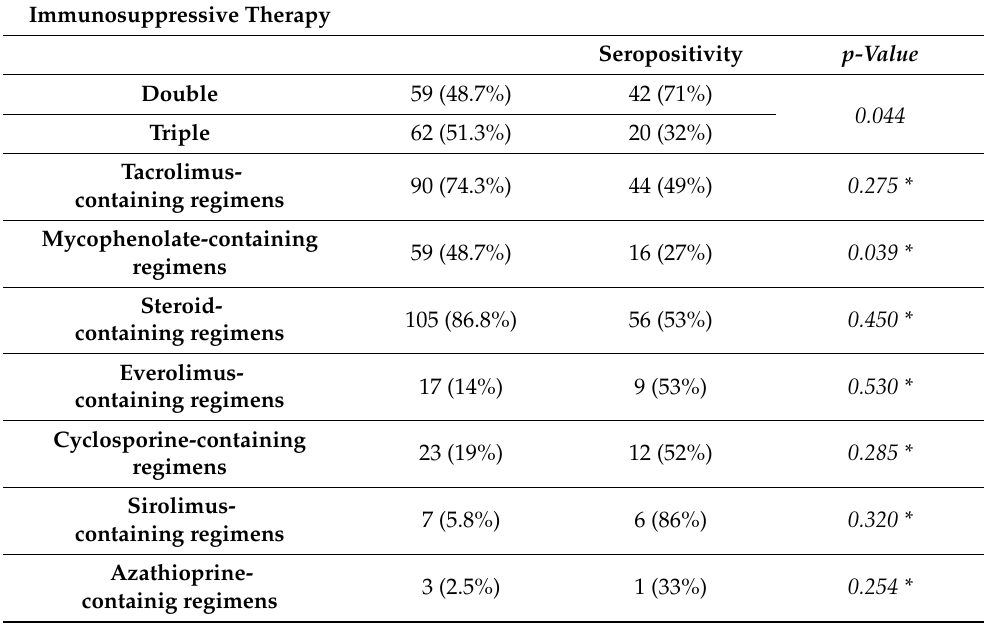
Table 2. Immunosuppressive therapy and Ig anti-SARS-CoV-2 post-vaccination serological status (N =